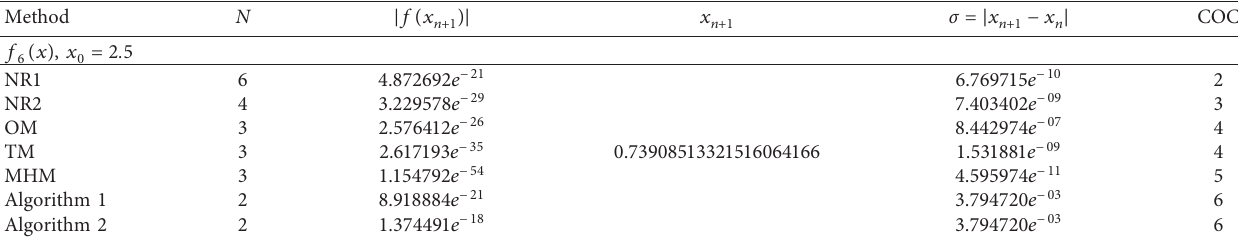
Table 6: Comparison of various iterative methods.